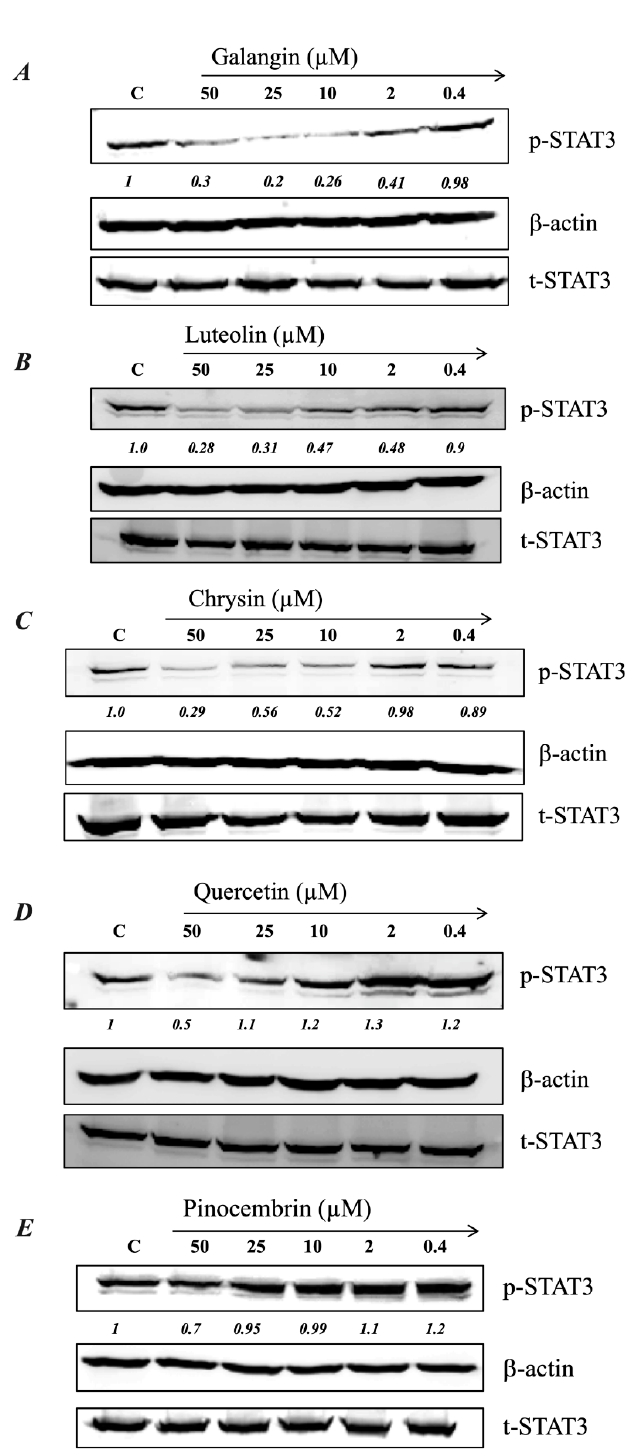
Figure 5. MH flavonoids inhibit p-STAT3 expression in breast cancer cells. Cells were treated for 1 h with various concentrations (0.4–50 μ M) of galangin ( A ), luteolin ( B ), chrysin ( C ), quercetin ( D ), and pinocembrin ( E ). Whole-cell extracts were then subjected to Western blotting with antibodies specific to tyrosine-phosphorylated STAT3 (p-STAT3) or total STAT3 (t-STAT3) protein. The numbers below each blot indicate changes in band intensity compared to control, as determined by densitometric analysis. These values were used to calculate the approximate IC 50 doses (concentrations that induce 50% inhibition in p-STAT3 levels) for each flavonoid, as shown in the corresponding graphs in Figure 6A–E. The data are representative of at least duplicate experiments for each flavonoid compound.